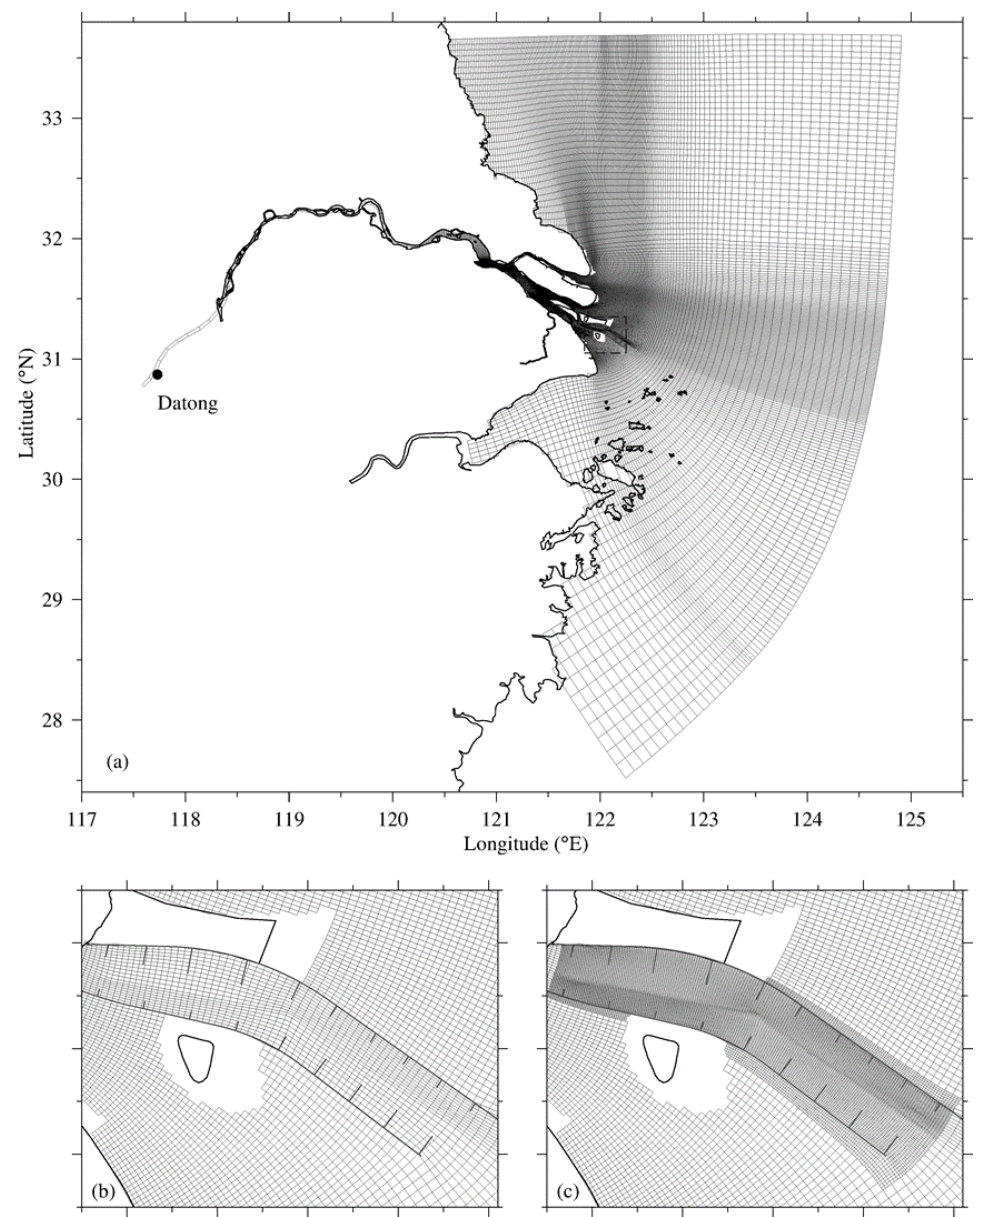
Figure 9. Numerical model grid showing a full horizontal structured curvilinear grid ( a ), a closeup of the structured grid ( b ), and the nested grid ( c ) in the Deep Waterway Project area. The tidal constants of 16 astronomical constituents (M 2 , S 2 , N 2 , K 2 , K 1 , O 1 , P 1 , Q 1 , MU 2 , NU 2 , T 2 , L 2 , 2N 2 , J 1 , M 1 , and OO 1 ), which are derived from the NaoTide dataset